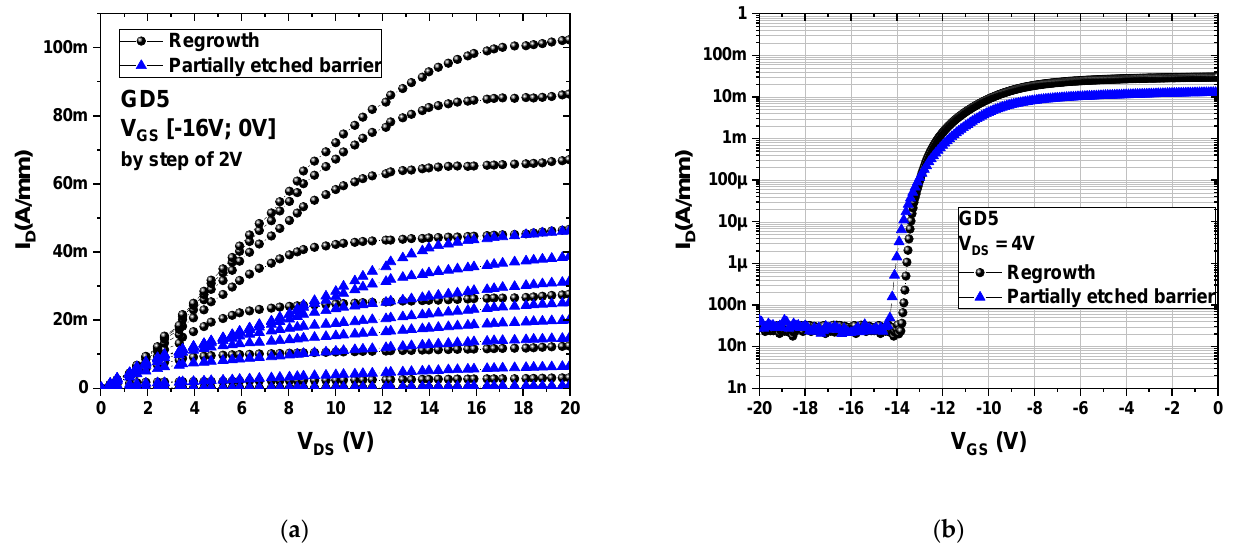
Figure 5. Output characteristics ( a ) and transfer characteristics ( b ) for a gate-drain distance of 5 µm of AlN/AlGaN/AlN HEMTs using regrown ohmic contacts and partially etched barrier.